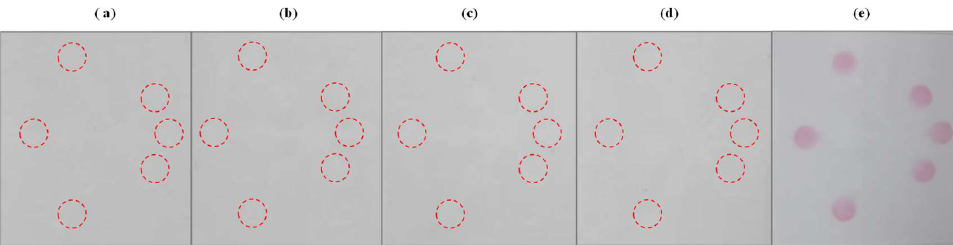
Figure 7. Selectivity of the μPADs to the addition of ( a ) Na + , ( b ) Ca 2+ , ( c ) SO 42− , ( d ) Fe 2+ , and ( e ) nitrite and nitrate.